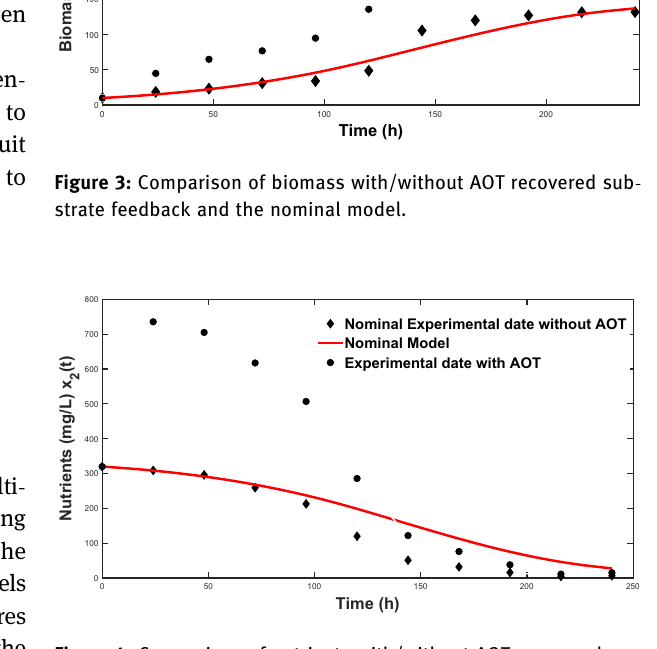
Figure 4: Comparison of nutrients with/without AOT recovered substrate feedback and the nominal